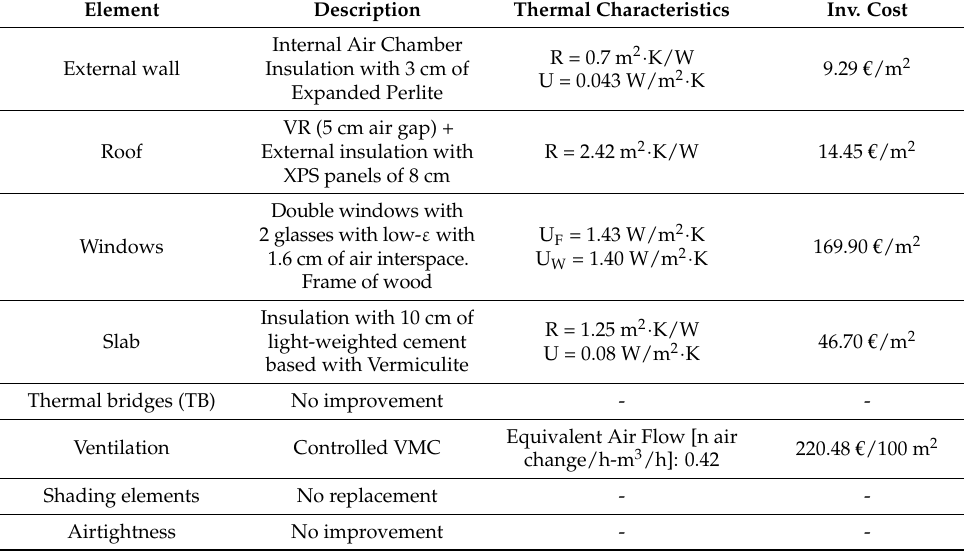
Table A11. POS12s: Renovation measures of solution 7.